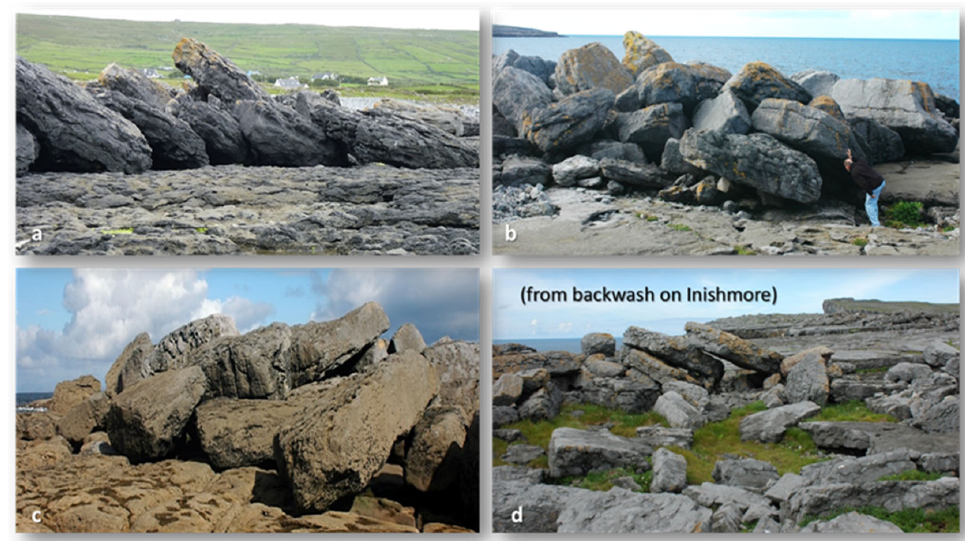
Figure 6. ( a – c ) Massive imbrication of boulders up to 50 tons about 15 km inside Galway Bay along limited water depth where all storm waves >5 m today lose energy by ground touching. Incorporated boulders go back to 6000 cal BP, when sea level was 5 m lower as was wave energy; ( d ) landward dipping imbrication from backwash at around +10 m mhw and >100 m inland from the south coast of Inishmore.